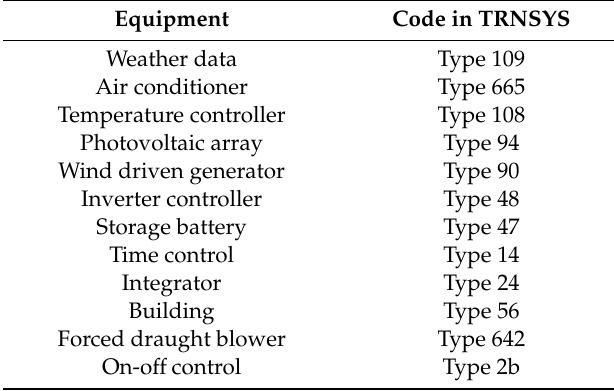
Table 2. The equipment of building renewable energy system in